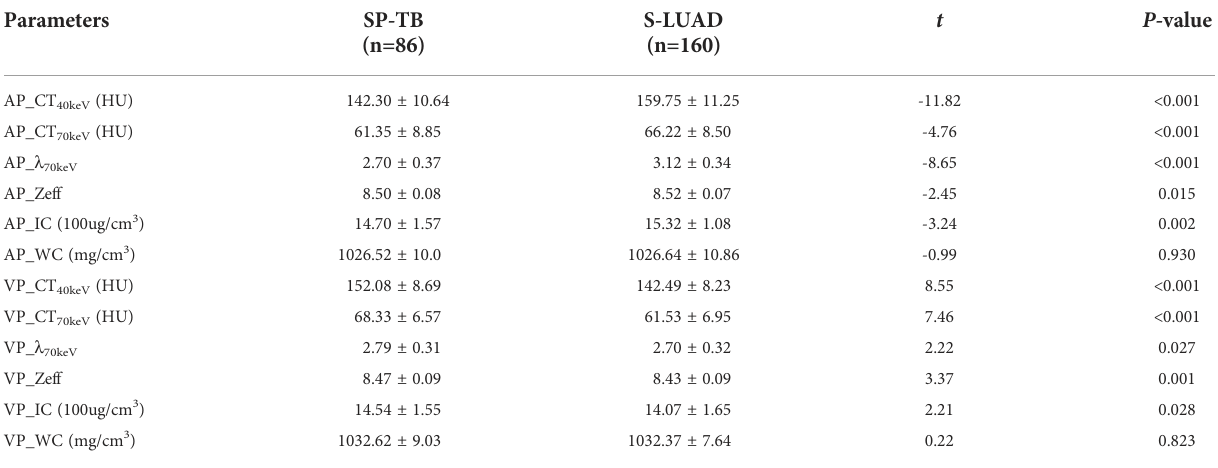
TABLE 2 Comparison of spectral CT parameters of SP-TB and S-LUAD in AP and VP.